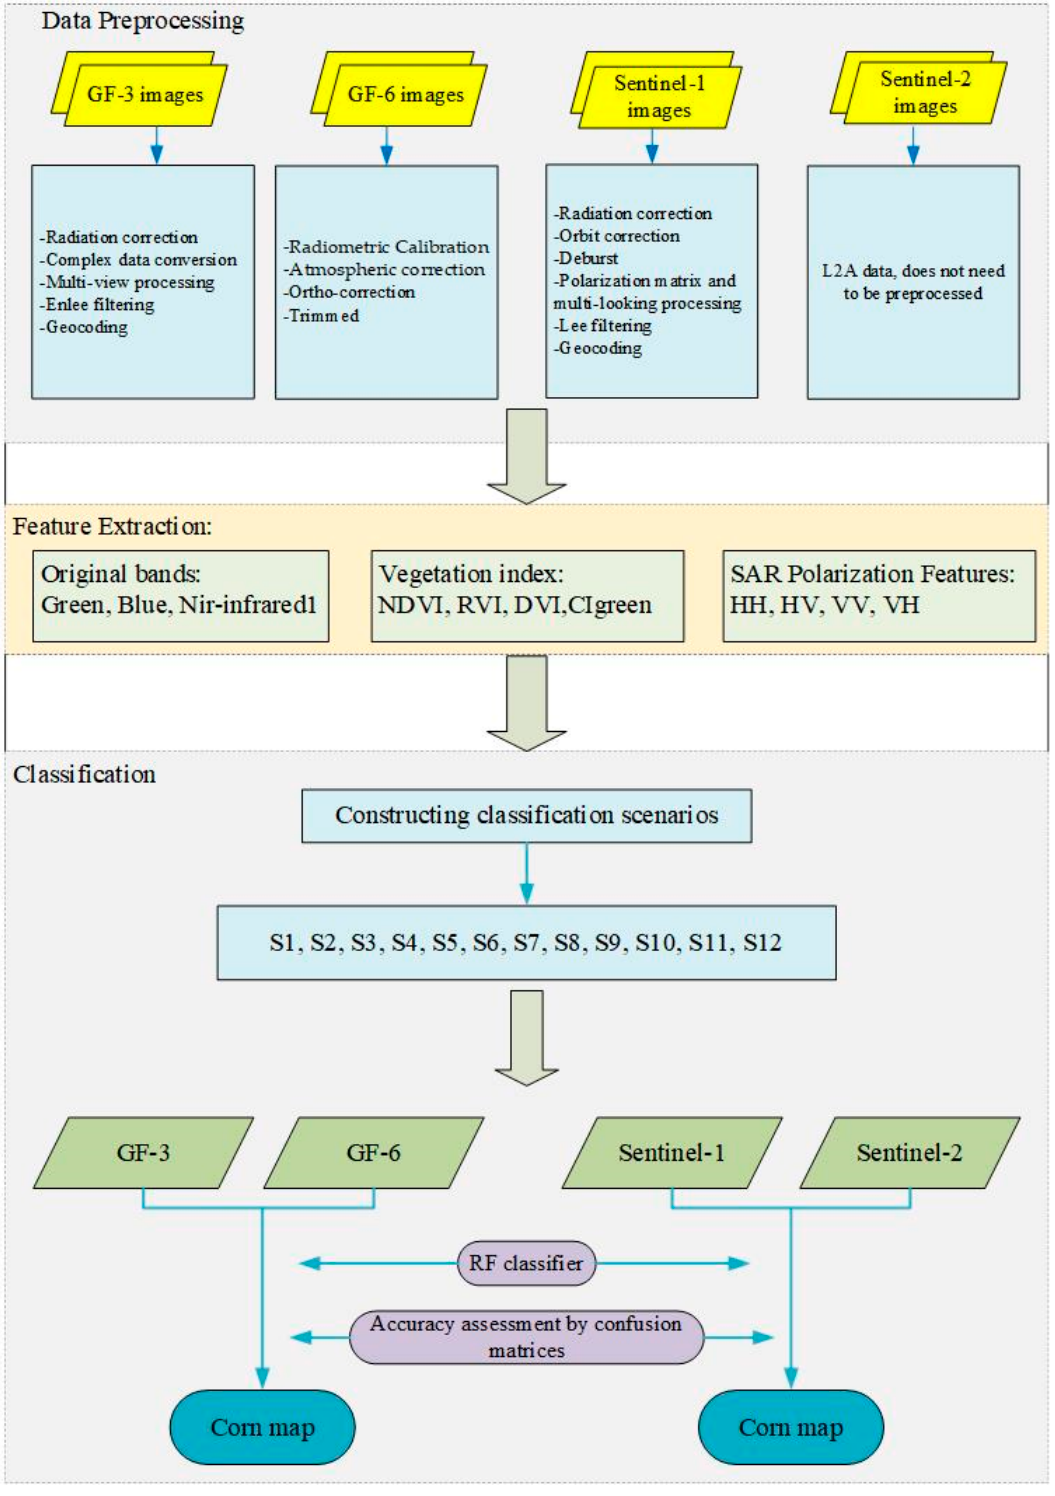
Figure 3. Workflow methodology of corn land extraction .